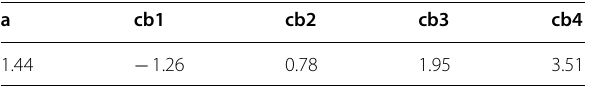
Table 1 IRT Calibration Statistics for PROMIS Fatigue item FATEXP42: How much mental energy did you have on